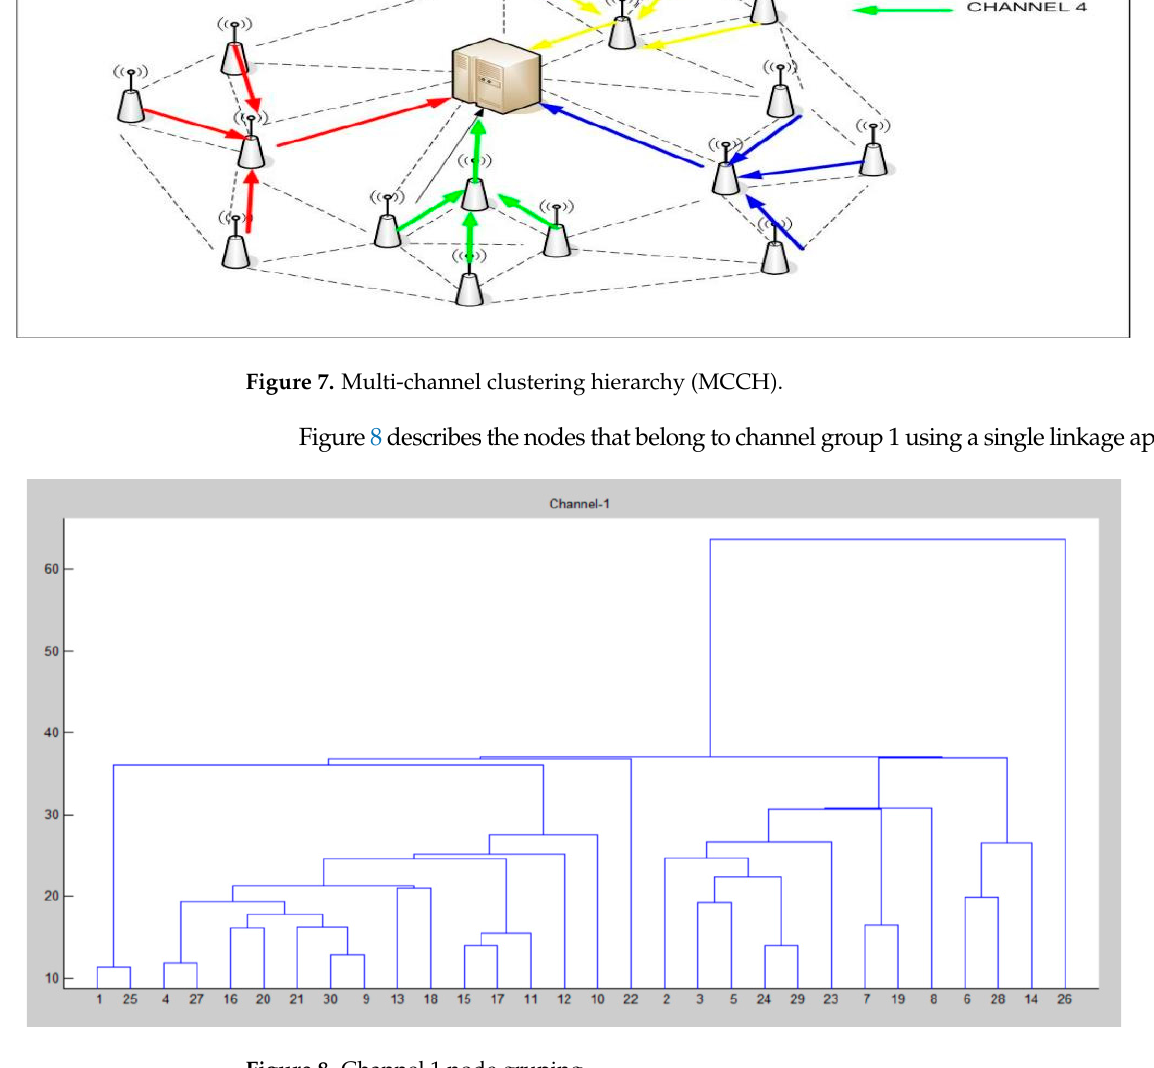
Figure 8. Channel 1 node gruping.